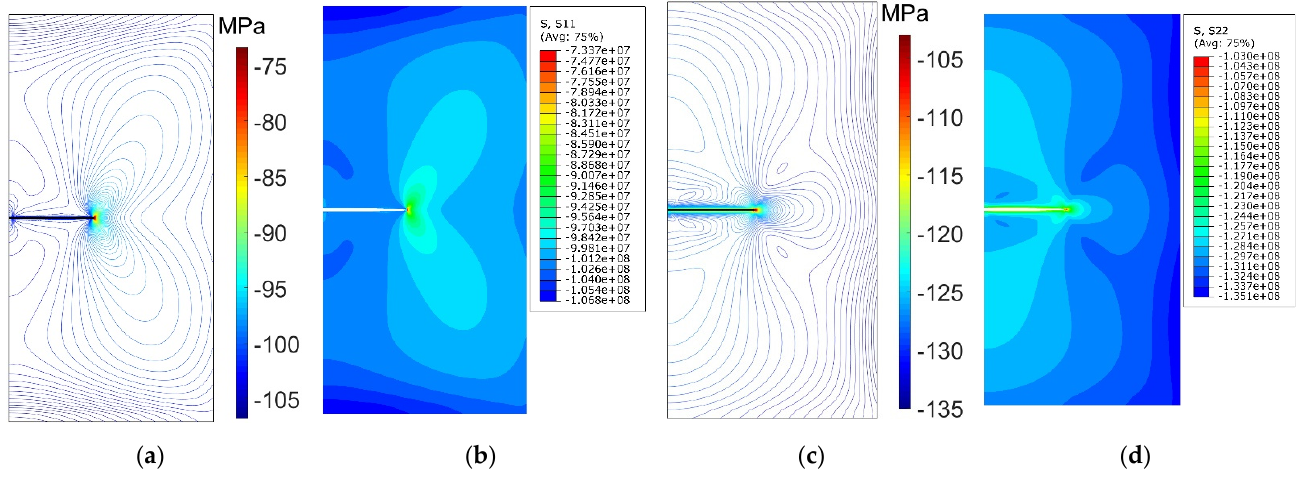
Figure 8. Distribution of stress (t = 3.58 × 10 2 s): ( a ) sigma_yy by EDFM — XFEM model; ( b ) sigma_yy by FEM model; ( c ) sigma_xx by EDFM — XFEM model; and ( d ) sigma_xx by FEM model.